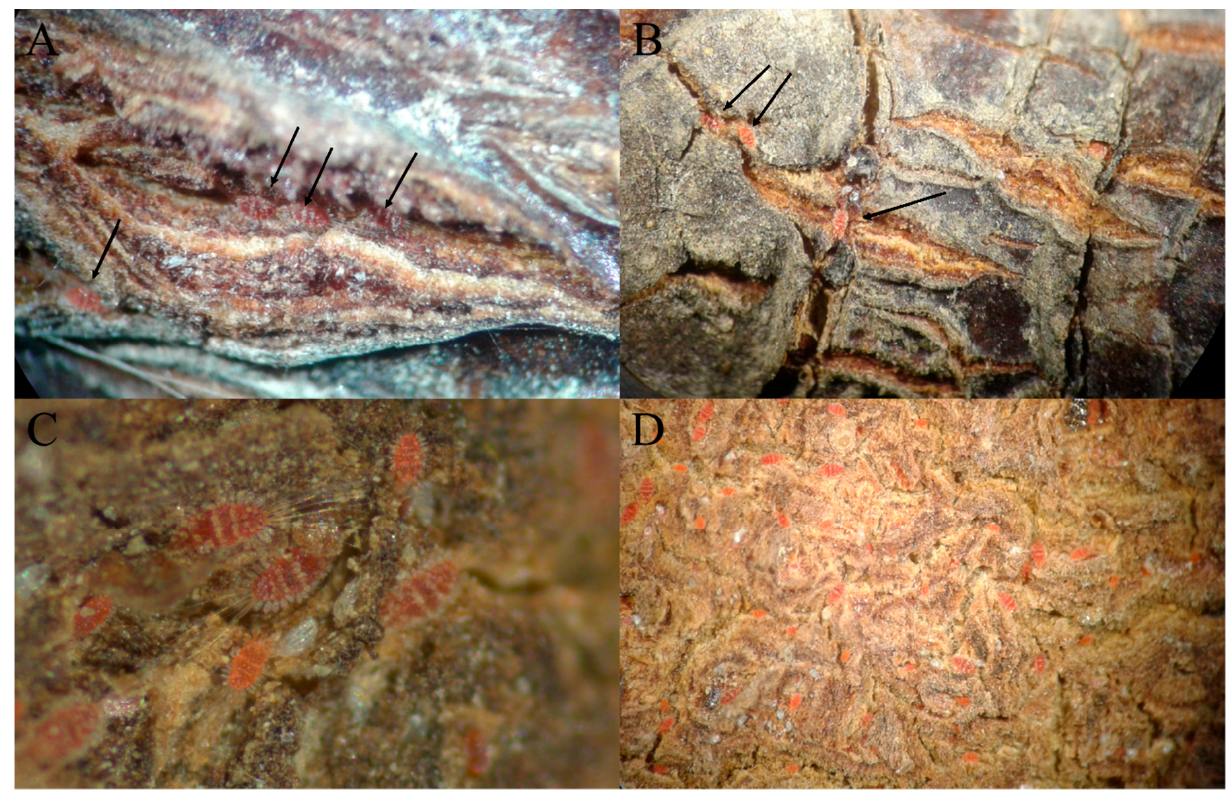
Figure 5. Aggregations of adult Tuckerella pavoniformis on Mammea americana with one or more eggs and/or immatures (indicated by black arrows) on branchlets sections ( A , B ) and fruit epicarp ( C , D ).